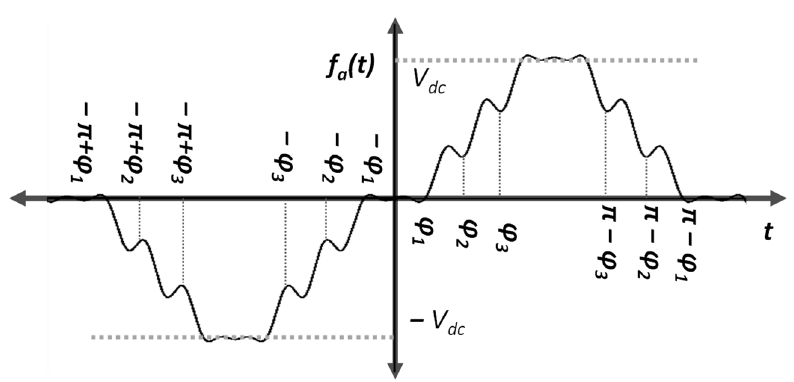
Figure 5. 5-level approximated waveform.